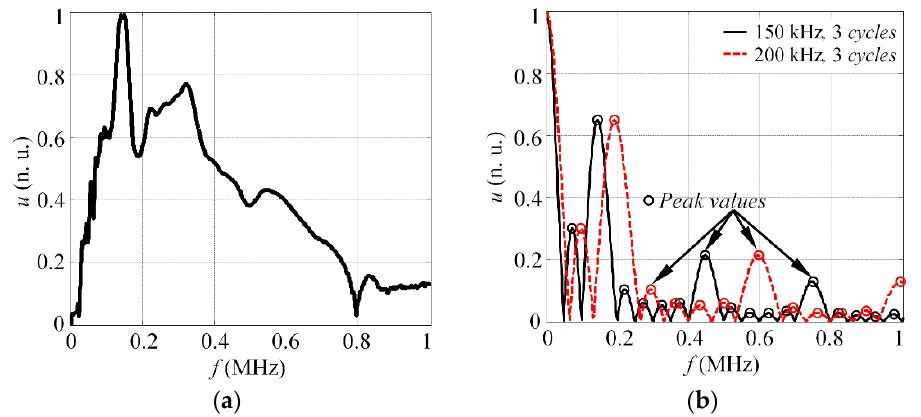
Figure 4. ( a ) The frequency response of the thickness mode transducer used for the experiments; ( b ) the magnitude spectra of three cycles (150 kHz) (solid line) and three cycles (200 kHz) (dashed line) square excitation pulse.